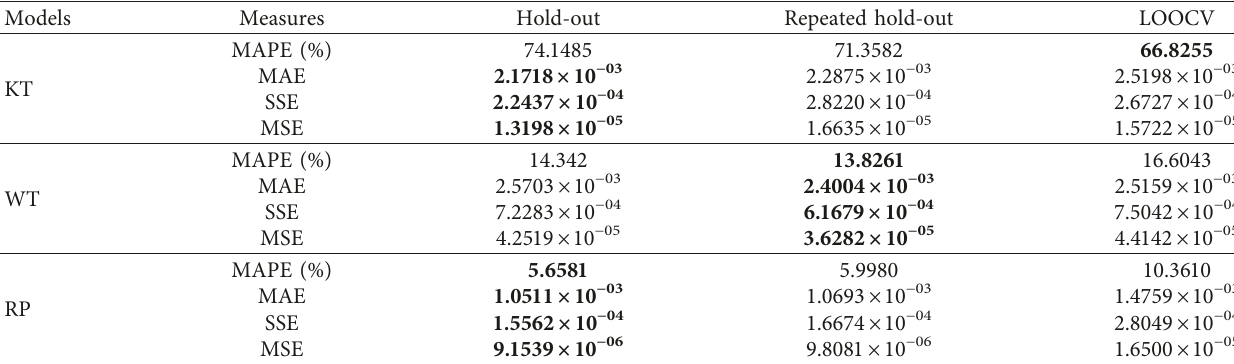
Table 8: Results of the goodness-of-fit measures for the women’s mortality.